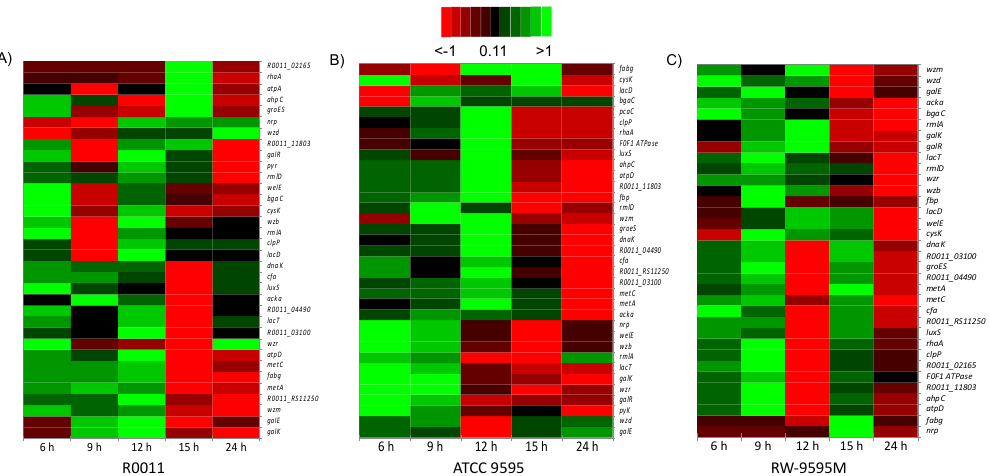
Figure 4. Heat map representation of the ratio of relative gene expression involved in carbohydrate catabolism, EPS operons, amino acid biosynthesis, lipid metabolism (cellular membrane, stress and cellular response) and other functions (microbial metabolism in diverse environments) over fermentation time (6, 9, 12, 15, 24 h) for L. rhamnosus strains R0011 ( A ); ATCC 9595 ( B ) and RW-9595M ( C ). Red shows under-expression while green denotes over-expression relative to the control condition (monoculture fermentation). Table 1. Relative expression ratio (RER) of genes involved in carbohydrate catabolism, EPS operons, amino acid biosynthesis and lipid metabolism, stress and cellular responses and other functions (microbial metabolism in diverse environments) of L. rhamnosus R0011 over 24 h during growth in whey permeate in co-culture with S. cerevisiae .